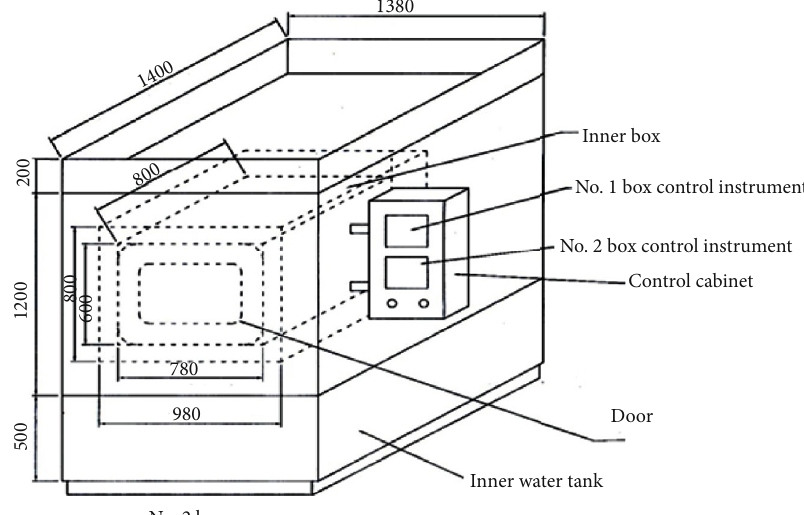
Figure 10: Design composition and principle of the soft rock gas adsorption